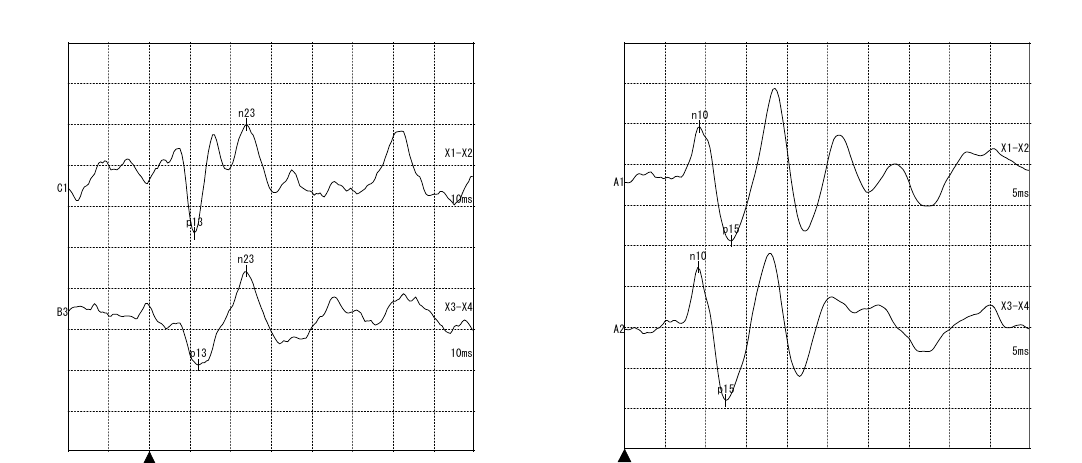
Figure 3. ( A ) Pure-tone audiometry (PTA) shows bilateral progressive sensorineural hearing loss in the proband. After a cochlear implantation (CI) in the right ear, sound field hearing threshold tests with a CI show 40 dBSPL. Red: right ear, Blue: left ear, Circle and Cross: Right and left ear air conduction hearing level respectively, Square bracket: Bone conduction hearing level, Triangle: both ears with intervention, Arrow: over measurement limit ( B ) There are no obvious differences between each ear in the cervical vestibular evoked myogenic potentials (right), and ocular vestibular evoked myogenic potentials (left).